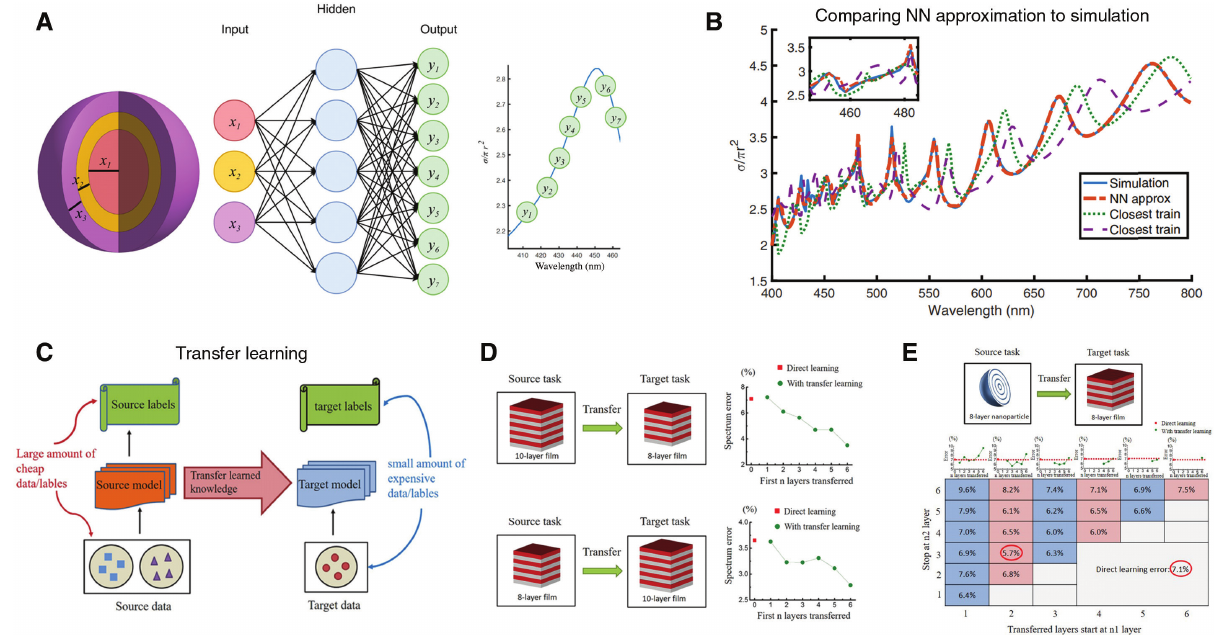
Figure 1: Forward modelling enabled by DL. (A) A schematic of DNN to predict scattering cross section of the core-shell nanoparticle. (B) Comparison of the approximated spectrum by NN to the simulation results, and closest data. (C) A schematic of transfer learning. Knowledge is transferred from the source data to target data. (D), (E) Results of the transferred learning between (D) similar and (E) different physical systems. (A) and (B) are adapted with permission from Ref. [49] (CC BY 4.0). (C–E) are reprinted with permission from Ref. [50], Copyright 2019 American Chemical